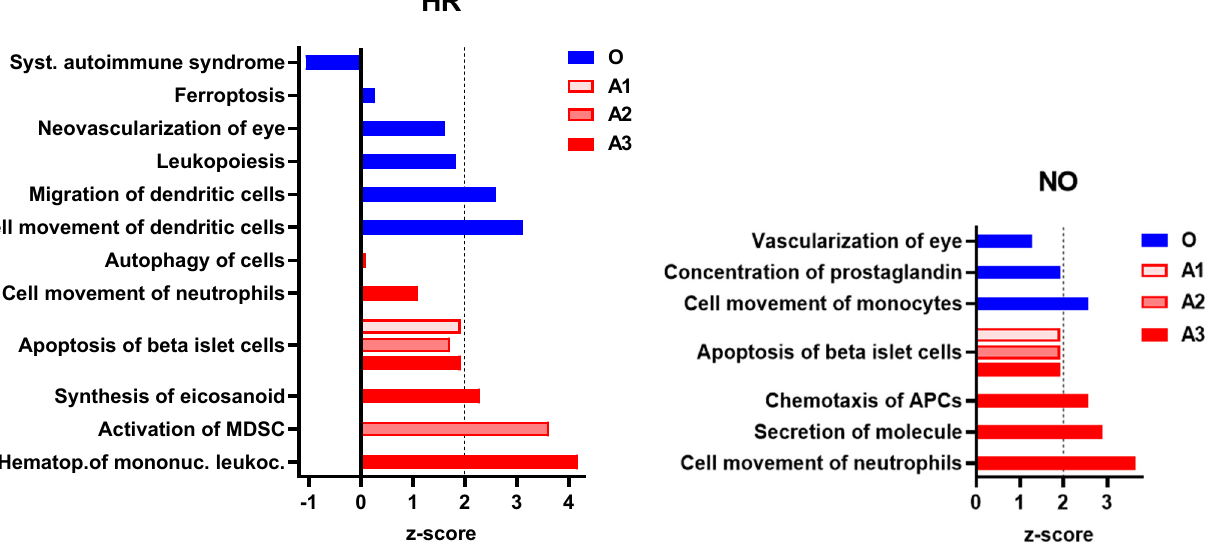
Figure 5. Immune and inflammatory diseases and functions exclusively predicted in the amplified (A1, A2, and A3) or original (O) integrated proteomics–metabolomics datasets for both the HR and NO subject groups (also see Figure 4 and Supplementary Table S3A,B for complete lists of predicted diseases and functions). Bar graphs show the z -scores, where positive values indicate predicted activation and negative values the inhibition of the specific immune disease and/or function ( z -score values ≤ –2 or ≥ 2 are considered significant; https://go.qiagen.com/IPA-transcriptomics- whitepaper, accessed on 27 August 2022).